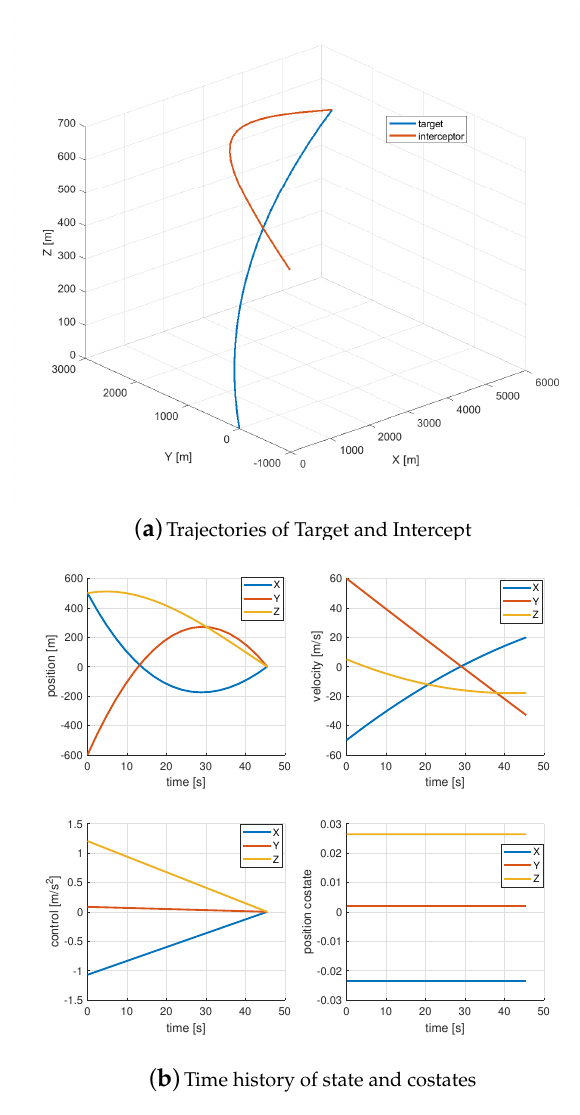
Figure 2. Unconstrained intercept problem with penalty Γ = 1 ( N = 20 and L = 16).